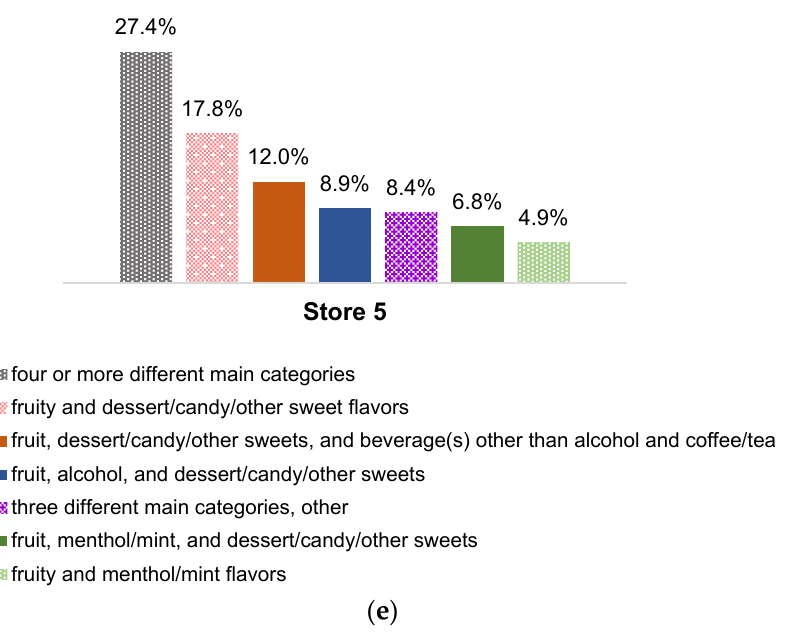
Figure 3. Top Seven Flavors in Each Online Vape Shop by Frequency Counts (Subfigures ( a – e ) show the top seven flavors by frequency counts in stores 1–5 respectively).